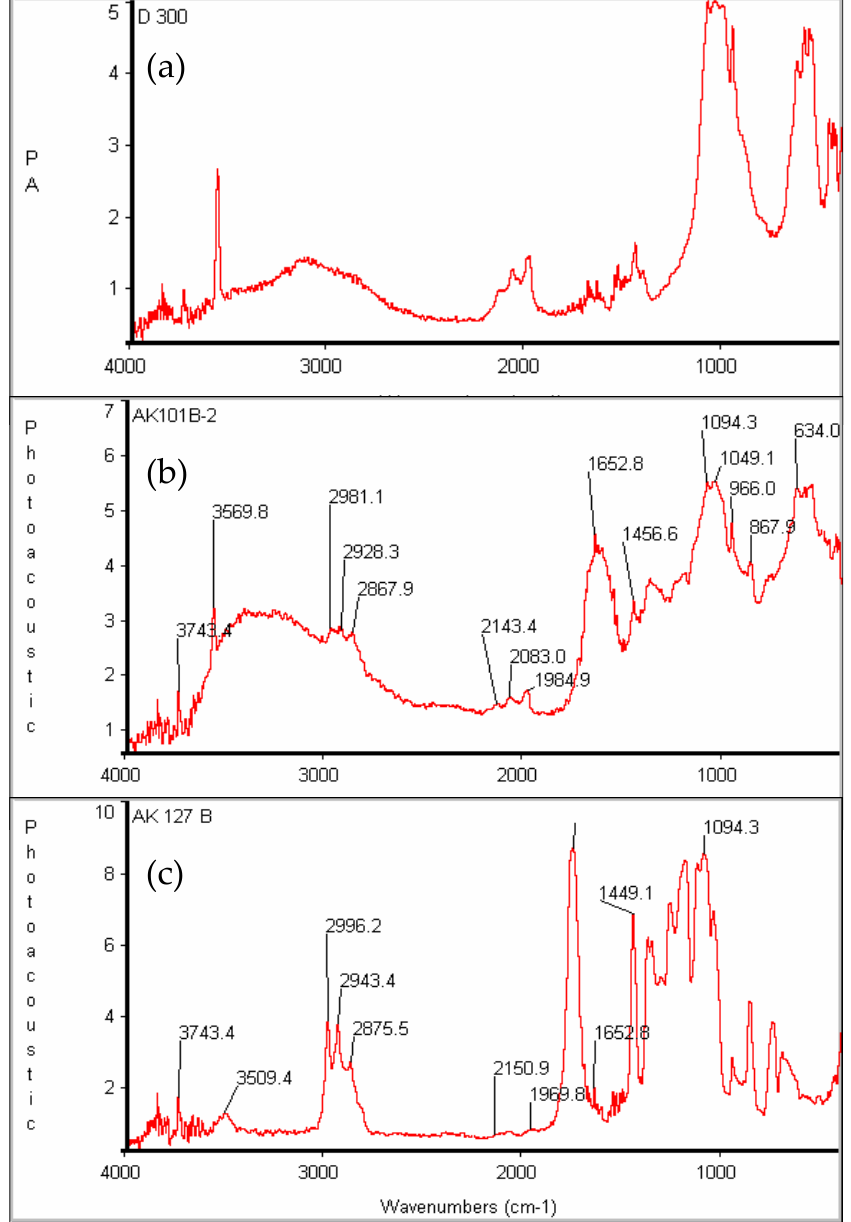
Figure 11. FT-IR spectra of ( a ) pure hydroxyapatite and HA-PDLLA formed by HA as the initiator with ( b ) (M)/(C) = 54 and ( c ) (M)/(C) = 217; see Table S1 for polymerization conditions. HA-PDLLA degradation behavior and phase compatibility in mixtures with com- mercially available PMMA based bone cement (Simplex P Speedset, Stryker Orthopae- dics) were investigated through TGA and DSC, respectively. An example with physical mixtures of 5 % weight HA-PDLLA 150 in bone cement is shown in Figures 12 and 13a,b. The simple physical mixture of the grafts with Simplex P Speedset does not deteriorate the thermal stability of the cement. Furthermore, the observed DSC curve for the same mixture exhibits the glass transition behavior of the original bone cement formulation (Figure 13b). Hence, the modification of standard bone cement formulations with 5 %